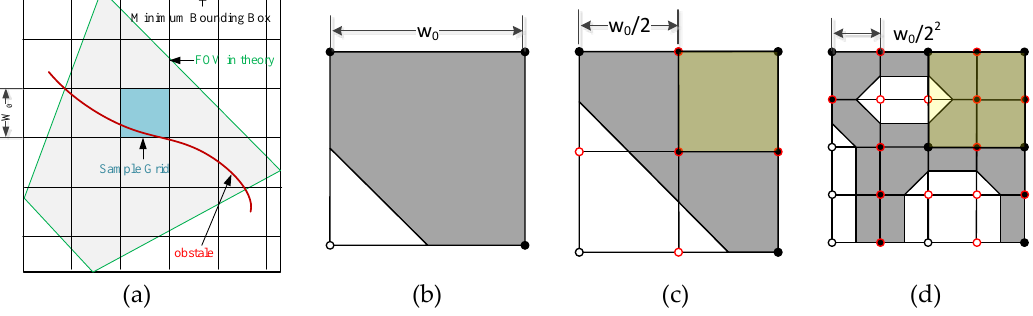
Figure 4. Different levels for grid-subdivision. ( a ) sample of FOV in theory; ( b ) sample grid ( l = 0); ( c ) sample grid ( l = 1); ( d ) sample grid ( l = 2).